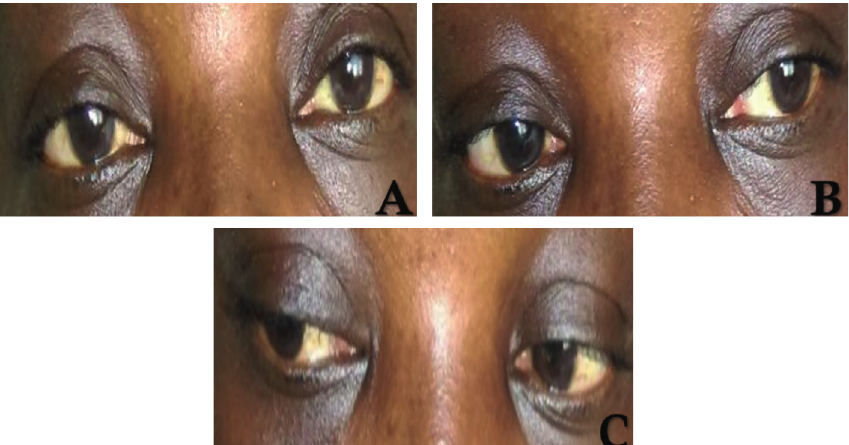
Figure 3: (a) Regression of right ptosis. (b) Complete remission of the third cranial nerve. (c) Complete remission of the sixth cranial